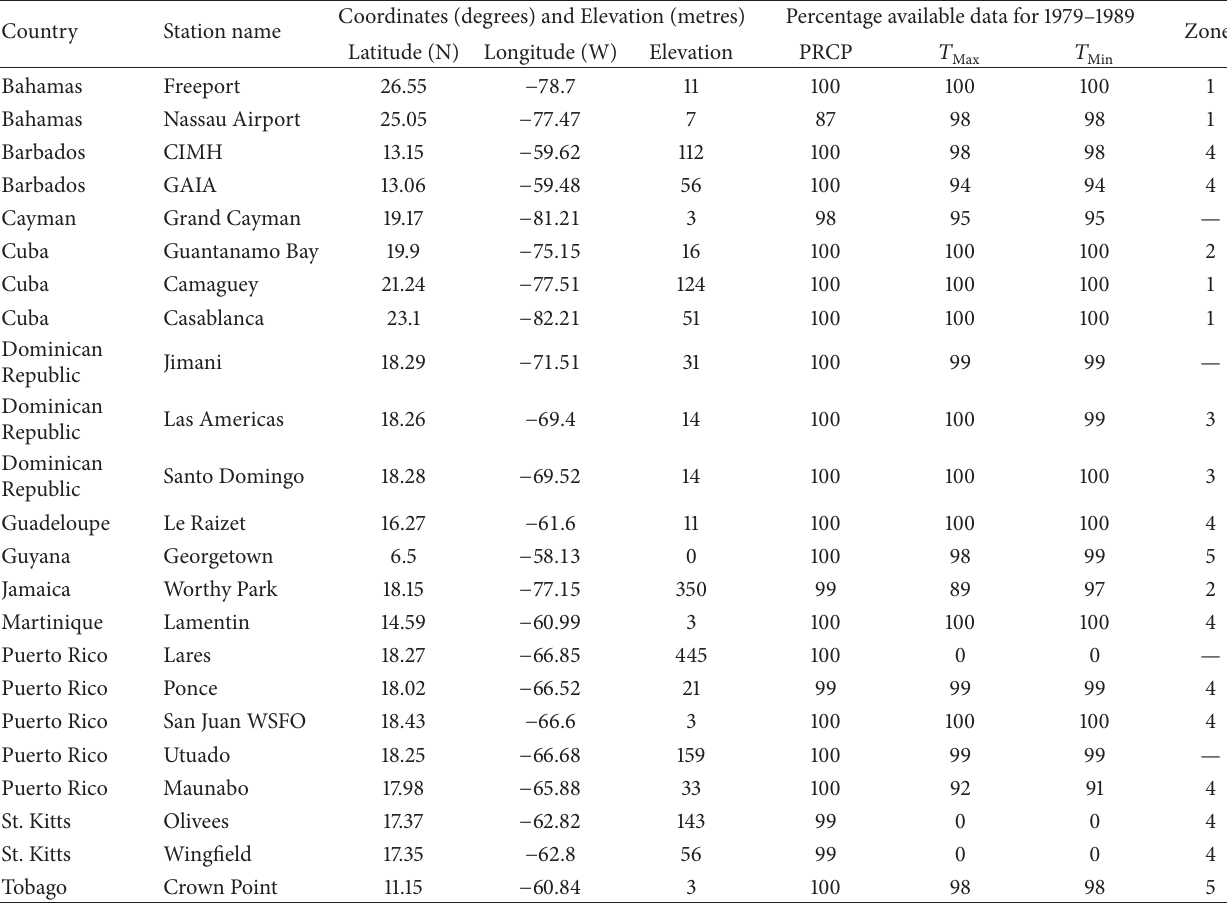
Table 1: List of observation station